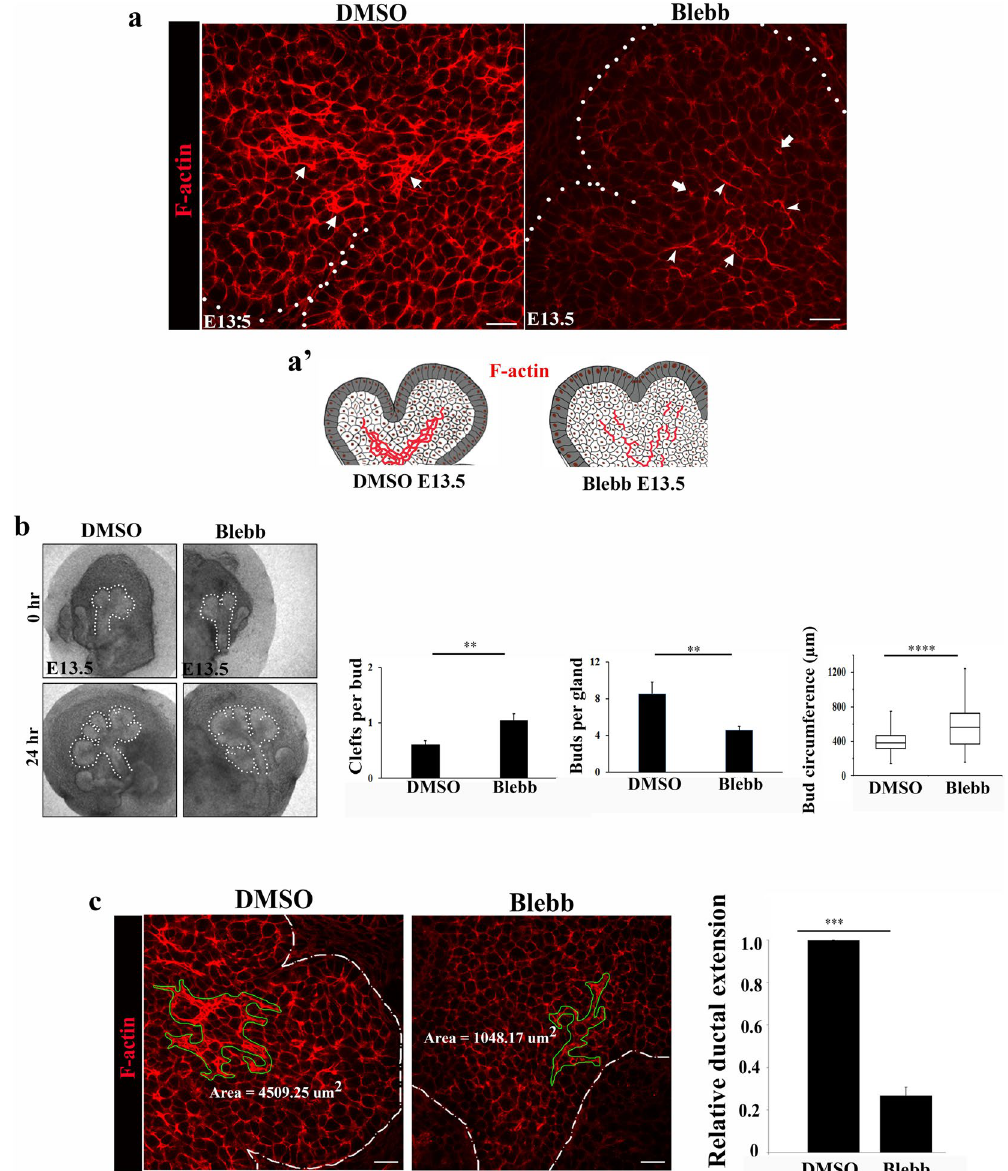
Figure 8. Inhibition of myosin IIB with blebbistatin abolishes F-actin localization to the sites of cellular asymmetry. ( a ) E13.5 SMGs treated with blebbistatin for 24 h displayed greatly reduced and interrupted F-actin staining in the proximal bud regions compared to expanded and continuous distribution of F-actin extending into the newly forming buds in the control DMSO-treated glands ( → ). ( a’ ) A schematic depicting changes in F-actin distribution from prominent deposition demarcating ductal paths to interrupted filaments. ( b ). Bright field images of the inhibitory effects of blebbistatin on branching morphogenesis of E13.5 SMGs (n = 15). Quantification of morphogenetic changes showed significant increases in numbers of shallow clefts ( p ≤ 0.01), reduction in bud numbers ( p ≤ 0.01) and greater bud circumference ( p ≤ 0.0001). ( c ) Quantification of inhibitory effects of blebbistatin on F-actin distribution (areas defined by green outlines) in proximal bud regions revealed a 3.3-fold reduction in F-actin expansion (bar graph, p ≤ 0.001). Size bars, 20